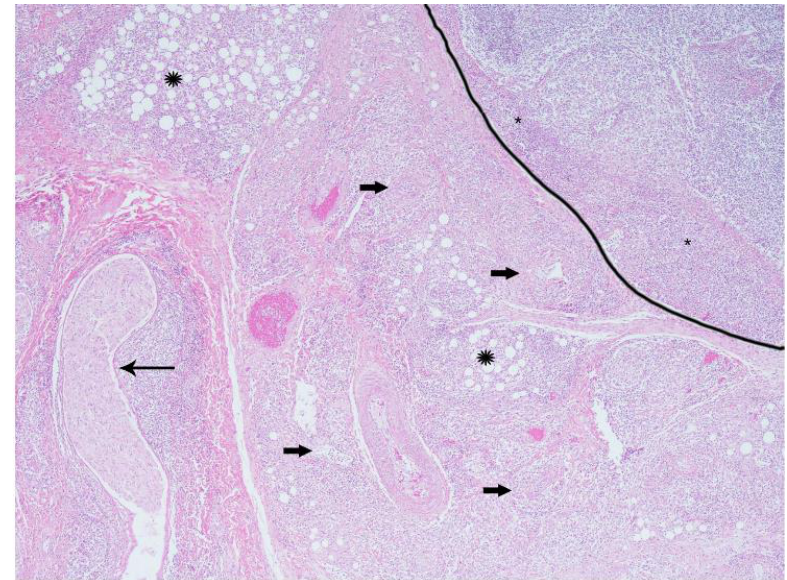
Figure 2. California sea lion, gastric lymph node and mesentery. The lymph node (outlined) has loss of normal cortical architecture with extensive mononuclear infiltrates in the subcapsular sinuses (asterisks). Some adjacent vessels (block arrows), nerve (arrow), and adipose tissues (starbursts) are surrounded and partially obscured by high numbers of mononuclear cells. Hematoxylin and eosin, 4× magnification.